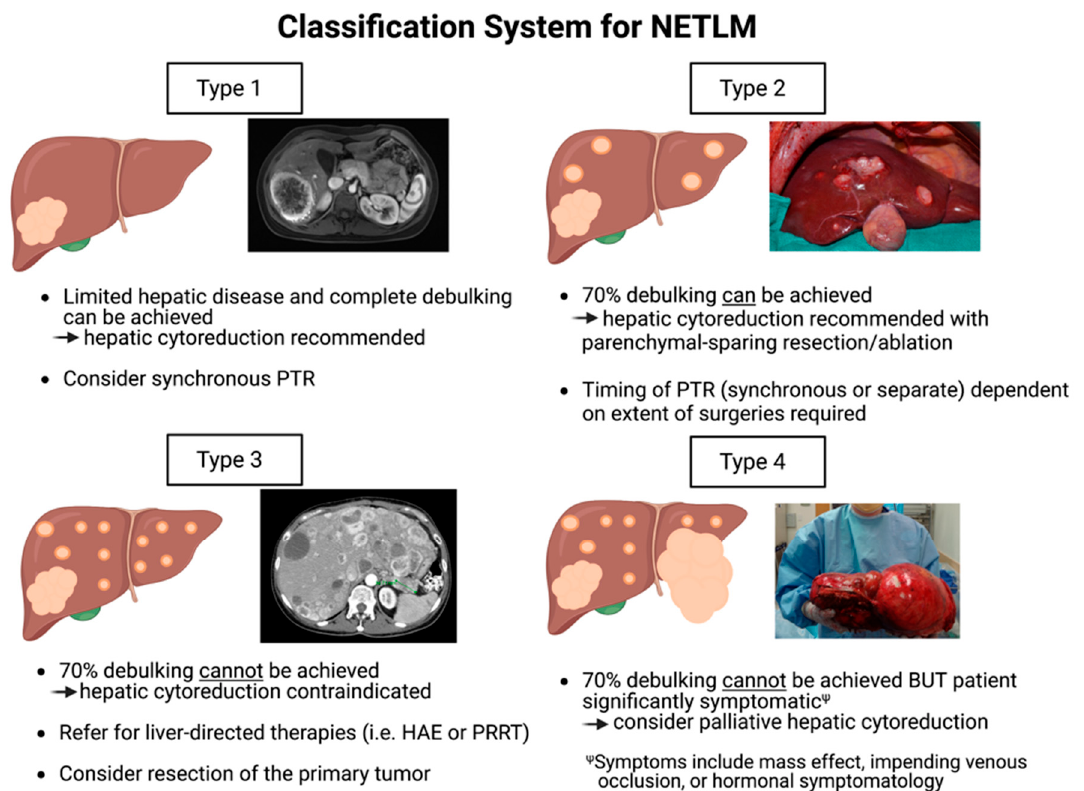
Figure 2. Proposed classification system of neuroendocrine tumor liver metastases (NETLM) to guide surgical management. The four types are defined by hepatic involvement, ability to achieve the recommended 70% debulking threshold with cytoreduction, and symptoms.